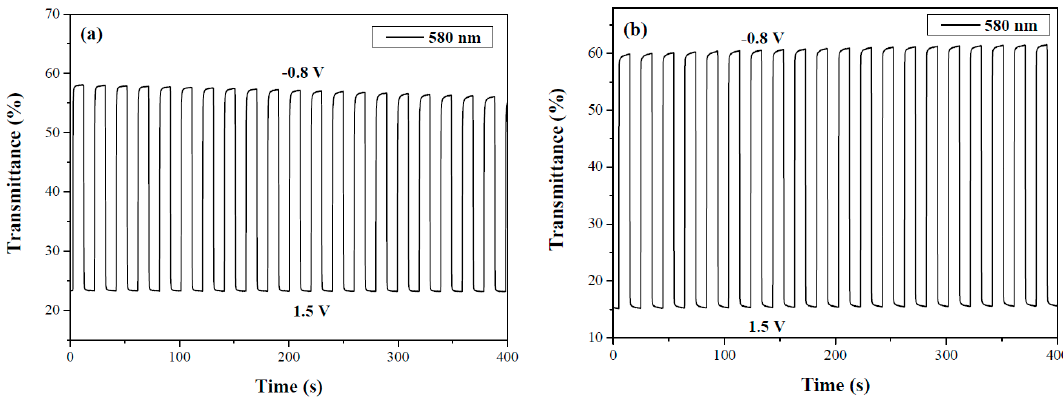
Figure 8. Optical contrast of ( a ) PdCz / PProdot-Me 2 and ( b ) P(dCz2- co -dTC2) / PProdot-Me 2 ECDs with a residence time of 10 s. Table 5. Optical and electrochemical properties investigated at the selected applied wavelength for the devices.